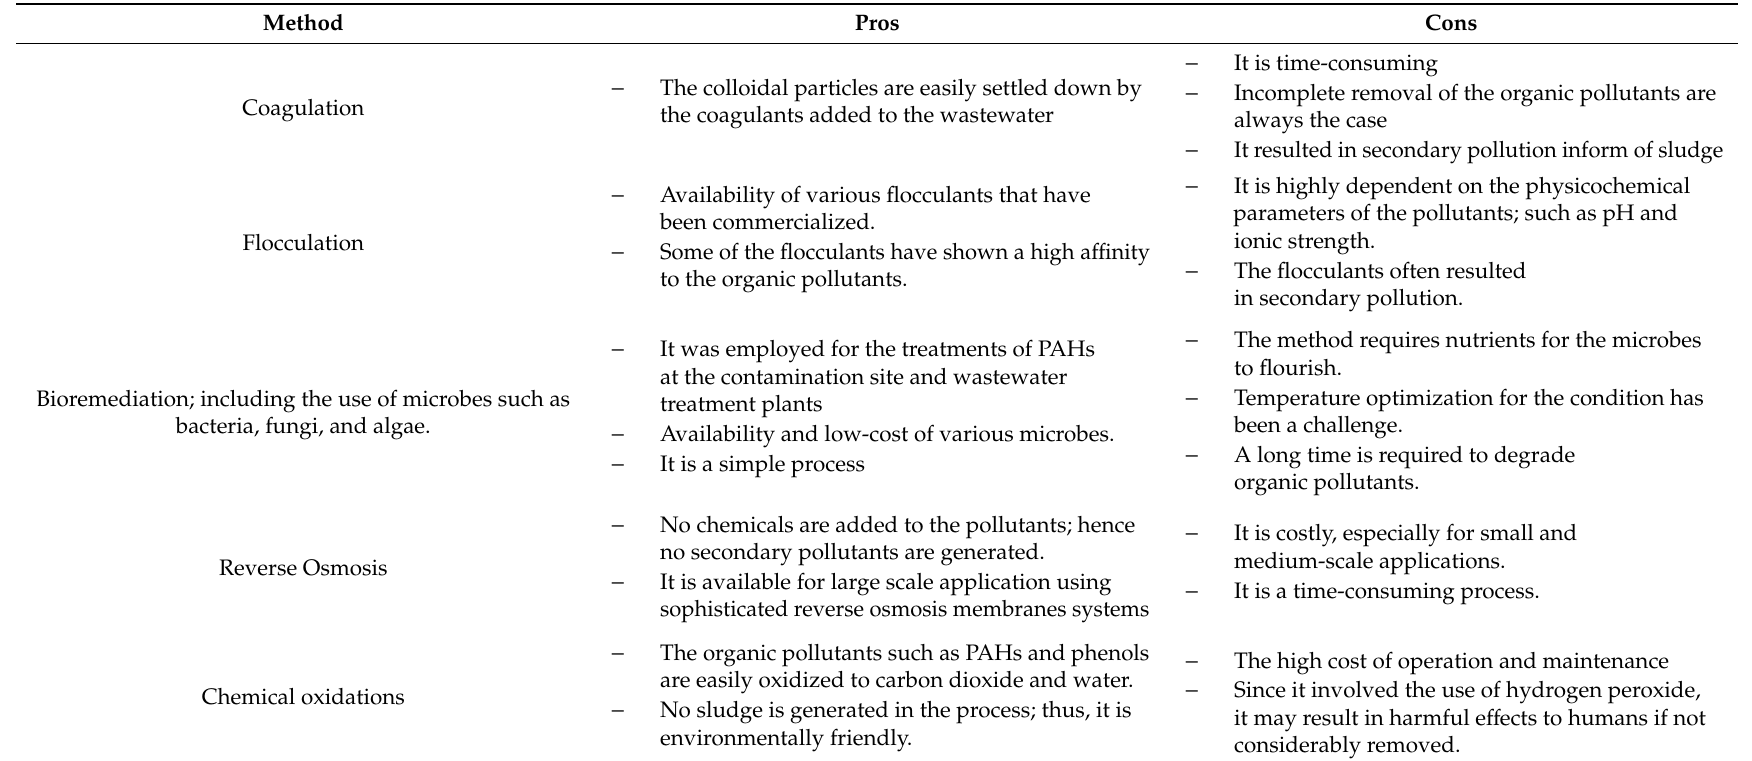
Table 3. Pros and Cons of Wastewater treatments process used for PAHs and phenols